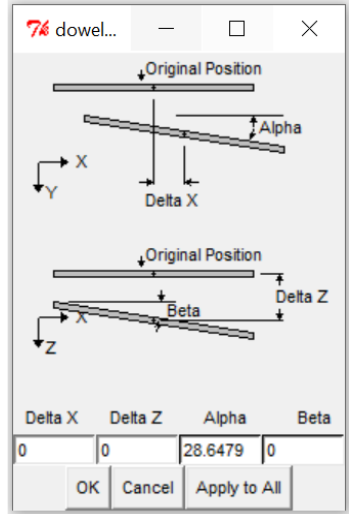
Figure 6. EverFE 2.25 window for determining dowel bars positions in the transverse